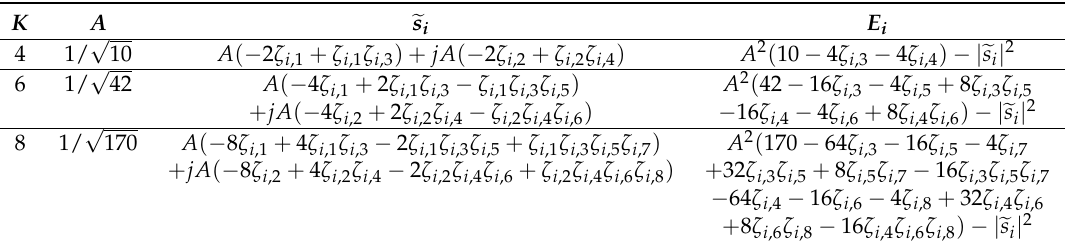
Table 1. Complexity reduced estimations of (cid:101) s i and E i by expanding (19)–(24) for a Gray coded quadrature amplitude modulation